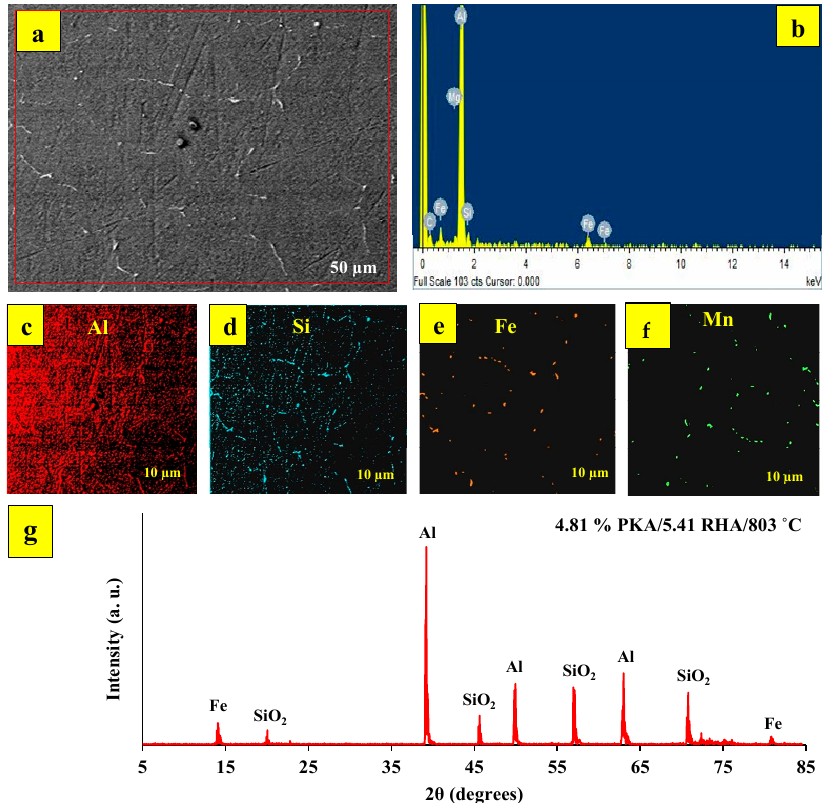
Figure 18. Characteristics of a sample prepared at optimum condition ( a ) microstructural features, Figure 18. characteristics of a sample prepared at optimum condition ( a ) microstructural ( b ) EDS elemental composition, ( c ) XRD phase features, ( b ) EDS elemental composition, ( c ) XRD phase identification.